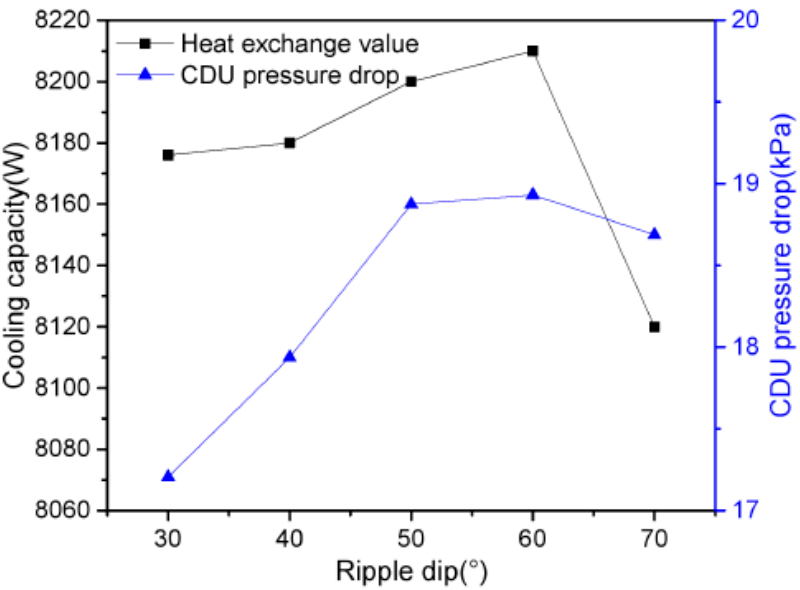
Figure 18. Variation of heat exchange capacity and pressure drop in the evaporator with the inclination of the corrugation.